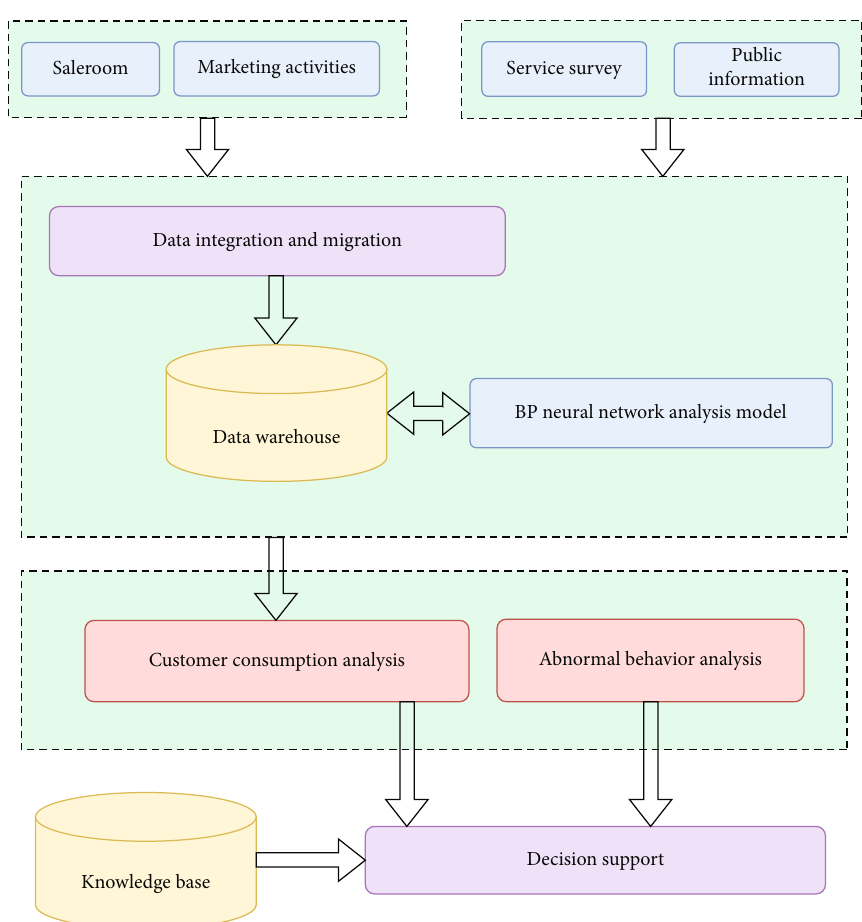
Figure 2: Customer behavior analysis model application